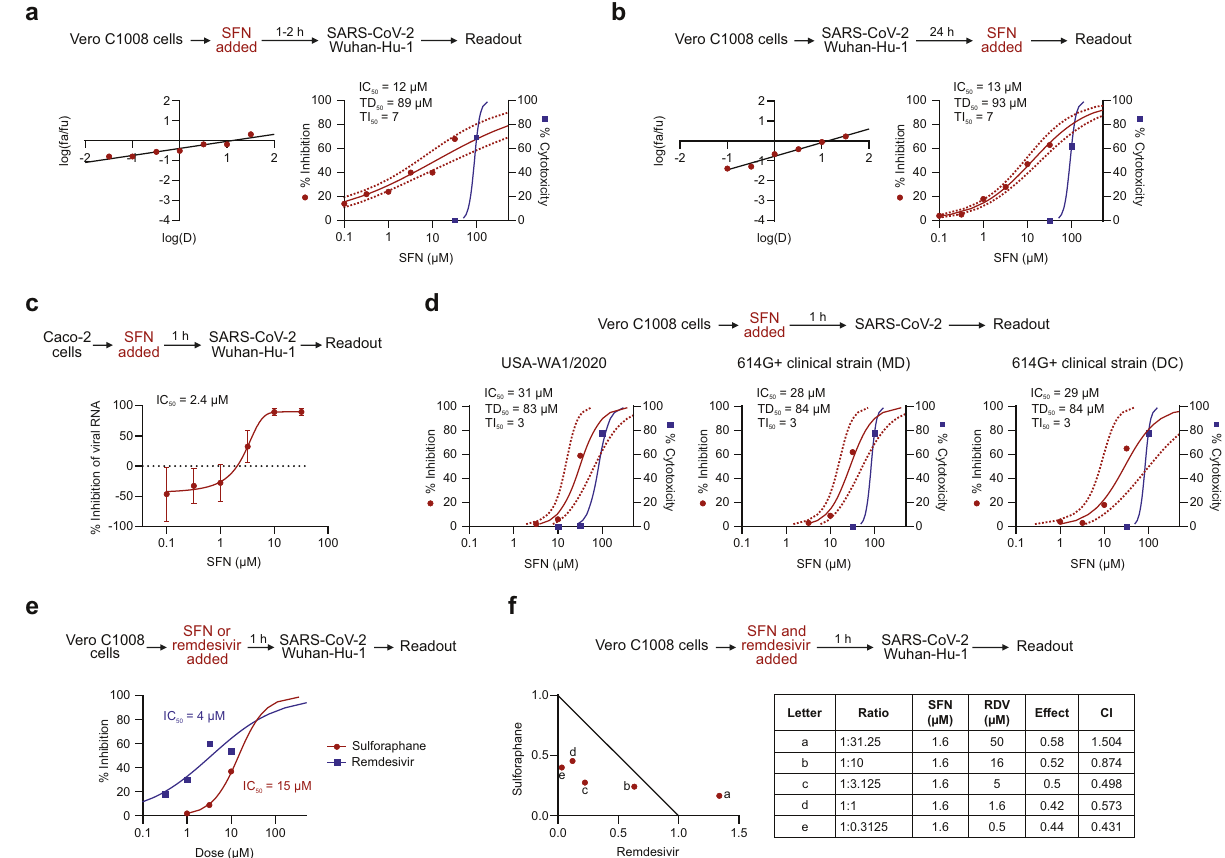
Fig. 2 Antiviral effects of SFN against SARS-CoV-2. Median effect plot and dose-effect curves calculated for a Vero C1008 cells infected with SARS-CoV- 2/Wuhan-Hu-1 after 1 – 2 h incubation with increasing concentrations of SFN; b Vero C1008 cells infected with SARS-CoV-2/Wuhan-Hu-1 for 24h and then incubated with SFN. Antiviral data is displayed in red; anti-host cell activity (cytotoxicity) is displayed in blue. c The antiviral activity in human Caco-2 cells was determined by measuring viral RNA by qPCR. The cells were incubated with SFN for 1 h before viral inoculation. d Effects of SFN evaluated in Vero C1008 cells exposed to drug for 1 h followed by viral inoculation. A reference strain (USA-WA1/2020) and two 614G + clinical strains of SARS-CoV-2 were evaluated for CPE using a bioluminescence readout. e Effects of SFN and remdesivir evaluated in Vero C1008 cells exposed to the drug for 1 h followed by viral inoculation. f Normalized isobologram showing combination index (CI) for combinations of various doses of SFN and remdesivir. Synergism (CI < 1); Additive effect (CI = 1); Antagonism (CI > 1); SFN, Sulforaphane; RDV, Remdesivir. Dotted lines represent 95% con fi dence interval. Experiments were performed a minimum of two times (range = 2 – 7), 3 – 6 replicates within each experiment, except the experiment shown in ( e ), which was performed